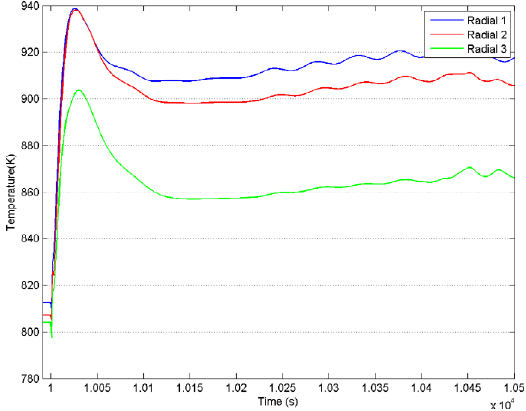
Fig. 11. Core outlet temperature (3D).